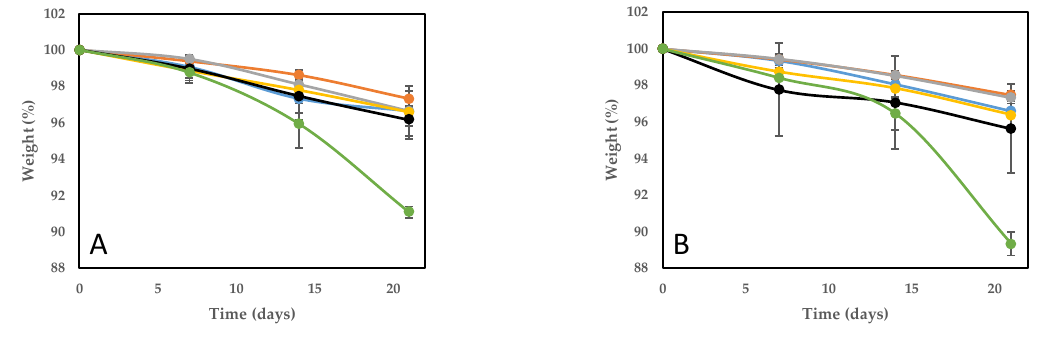
Figure 3. Effect of type of packaging and storage time (0, 7, 14, 21 days) at 4 °C on the blackberries’ ( A ) and raspberries’ ( B ) weight losses (expressed as percentage).